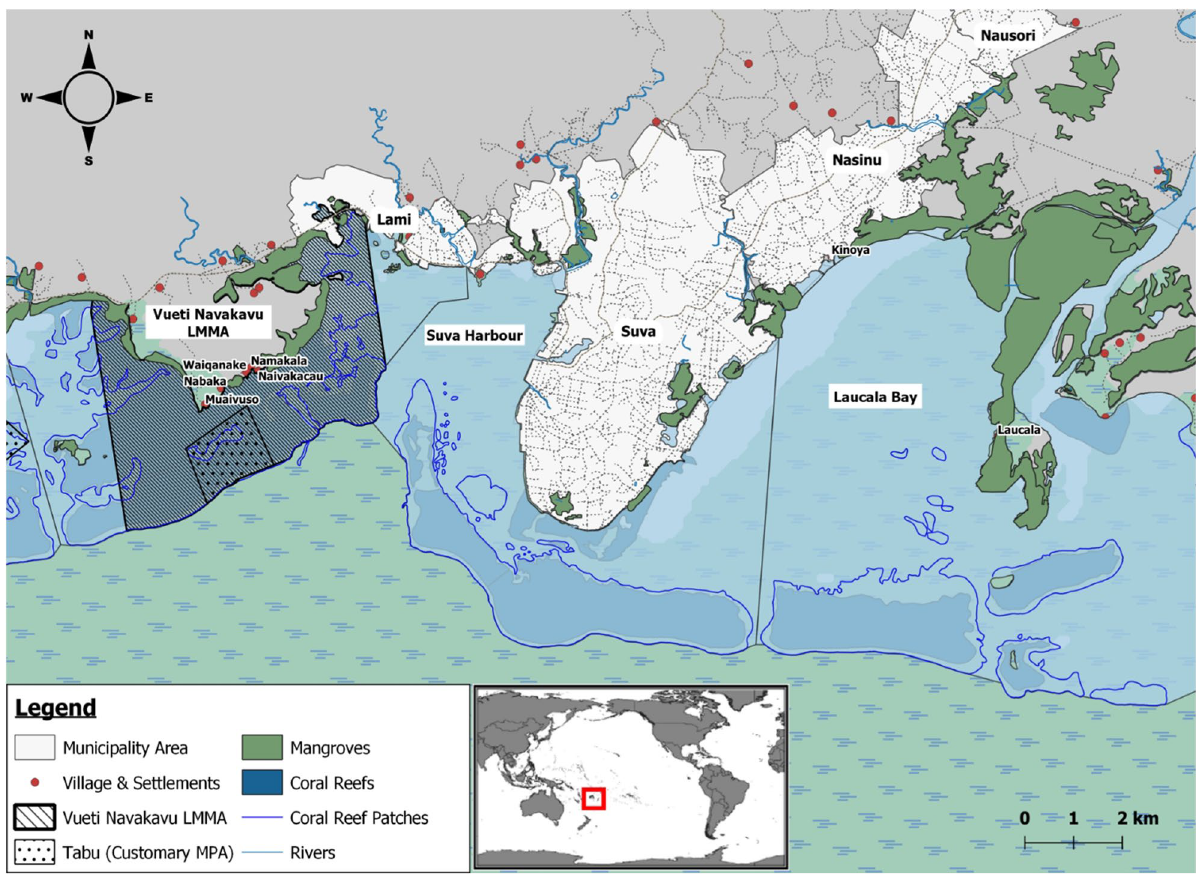
Figure 1. Vueti Navakavu locally managed marine area (LMMA) and its customary marine protected area ( tabu ) in Viti Levu, Fiji. Inset: location of Fiji within the Pacific Ocean. Maps produced with QGIS Development Team 57 ; maritime boundaries from the Secretariat of the Pacific Regional Environment Programme 58 —PacGeo